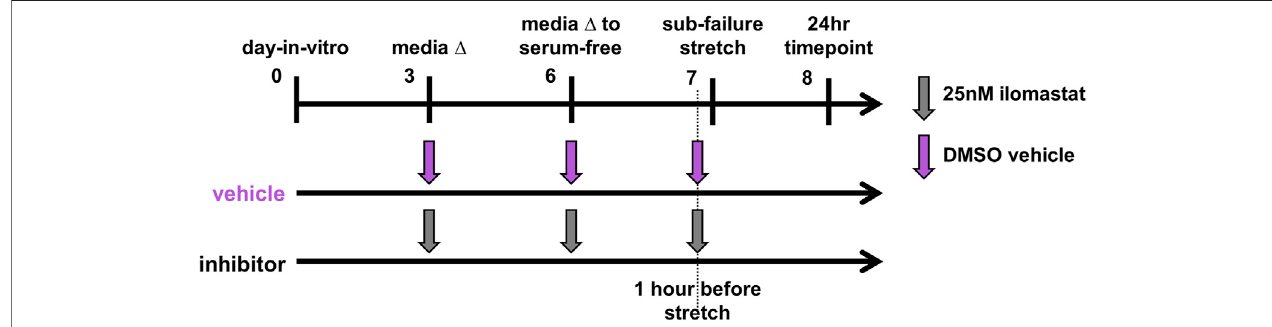
FIGURE 1 | Study design for co-culture gels receiving the ilomastat inhibitor ( n = 14) or DMSO vehicle ( n = 10). Co-cultures received either the ilomastat inhibitor (25 nM)orDMSOvehicleintotheirmediaatday-in-vitro3and6andonehourbeforeanequibiaxialstretchonday-in-vitro7.Allco-cultureswere fi xedforimmunolabeling assays 24 h after sub-failure